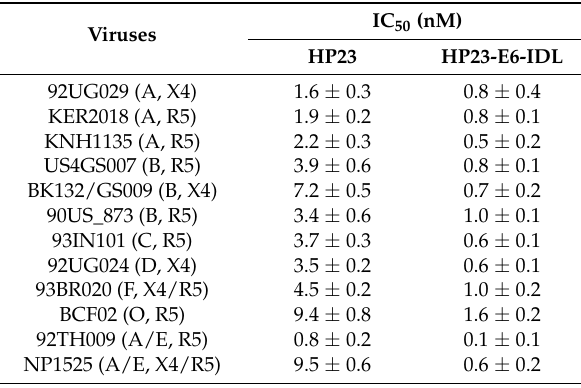
Table 1. Inhibitory activities of HP23 and HP23-E6-IDL against HIV-1 clinical isolates (subtype,